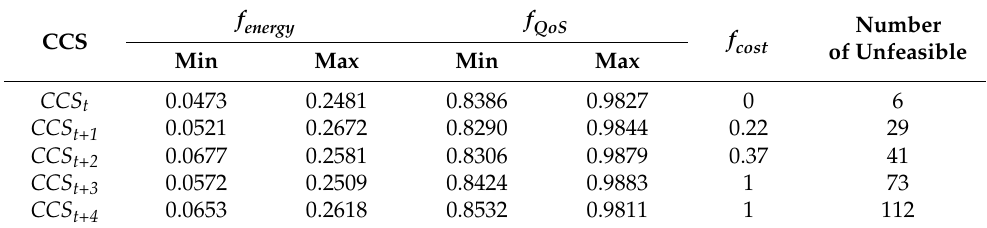
Table 6. Different adaptations of CCS with context